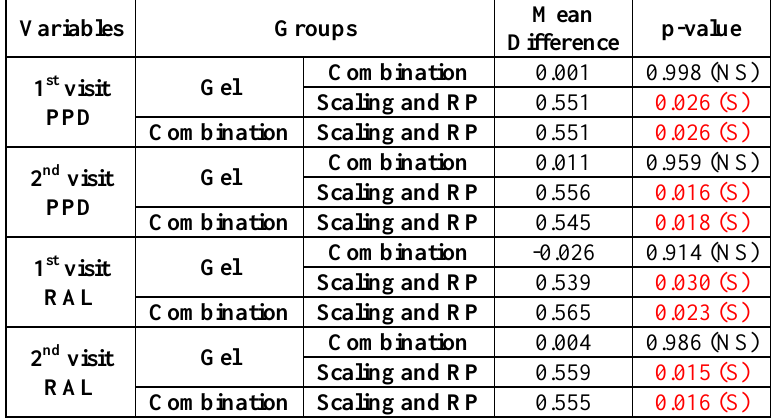
Table 2: Inter Groups Comparison of PPD and RAL between Each Pair of the Study Groups Using LSD Test at 1 st and 2 nd